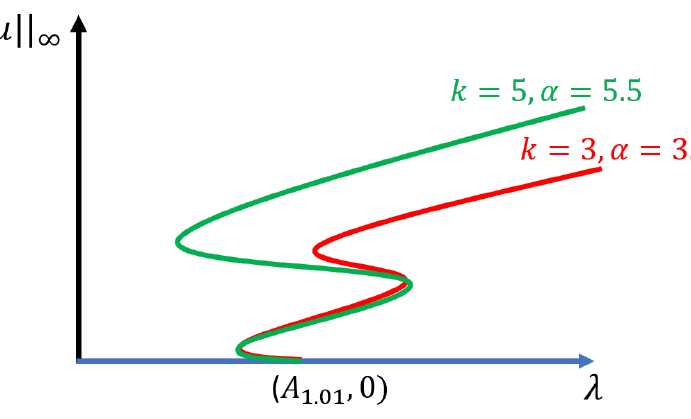
Fig. 11: The local view of the bifurcation diagrams near the bifurcation point ( A 1.01 , 0) when m = 0.01 and c = 2.5